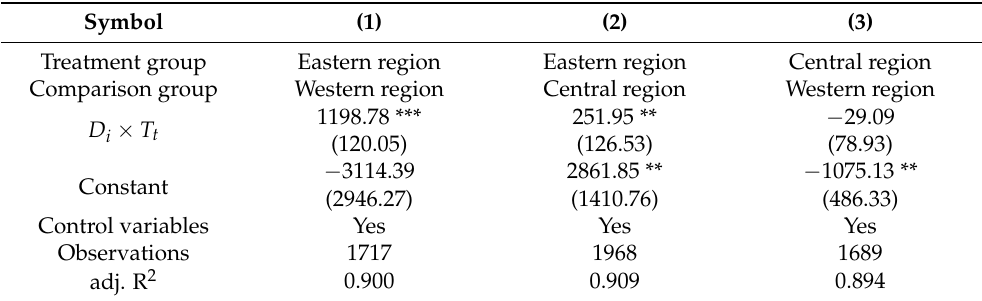
Table 2. Estimated results of Model